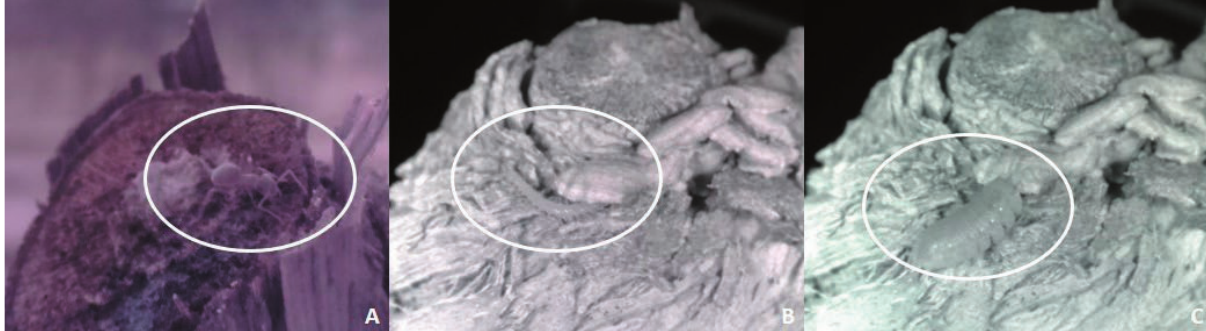
Figure 2. Images of arthropods visiting vine pruning wounds: A, an ant ( Formicidae : Formicinae ); B, a centipede ( Chilopoda : Lithobiidae ); C, a woodlouse ( Isopoda : Armadillidiidae